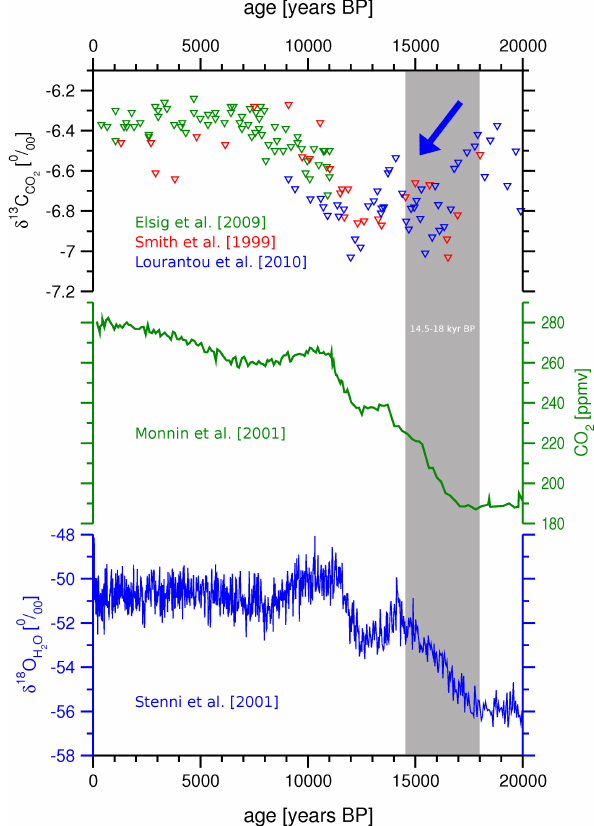
Fig. 11. Paleo-records from Antarctic ice cores: δ 13 C-data is from Elsig et al. (2009) (green triangles), Smith et al. (1999) (red tri- angles) and Lourantou et al. (2010) (blue triangles). The blue ar- row indicates the recorded drop in δ 13 C CO ( ∼ − 0.4‰) starting 2 around 18kaBP. CO 2 -data is from Monnin et al. (2001) and δ 18 O- data from Stenni et al.